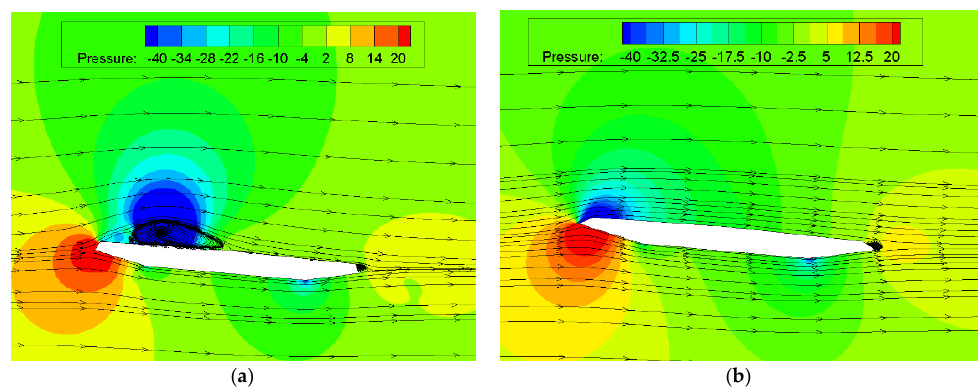
Figure 11. Winding flow pattern in the area near the deck with different wind fairing angles. ( a ) 62° wind fairing; ( b ) 40° wind fairing.